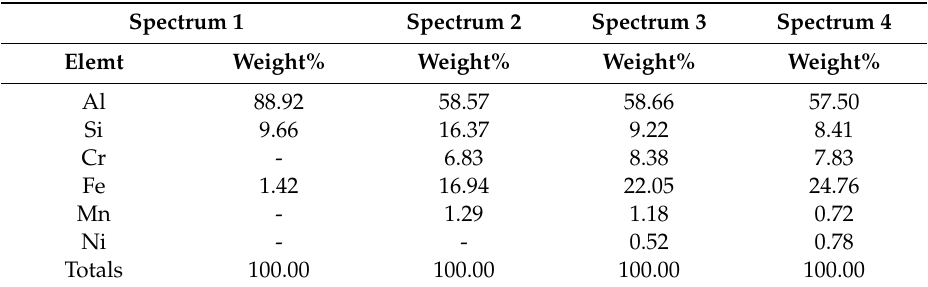
Figure 19. E 18 8 Mn B 2 2/680 ± 20 °C/120 min/AlSi9. EDX semi-quantitative microanalyses (mapping).